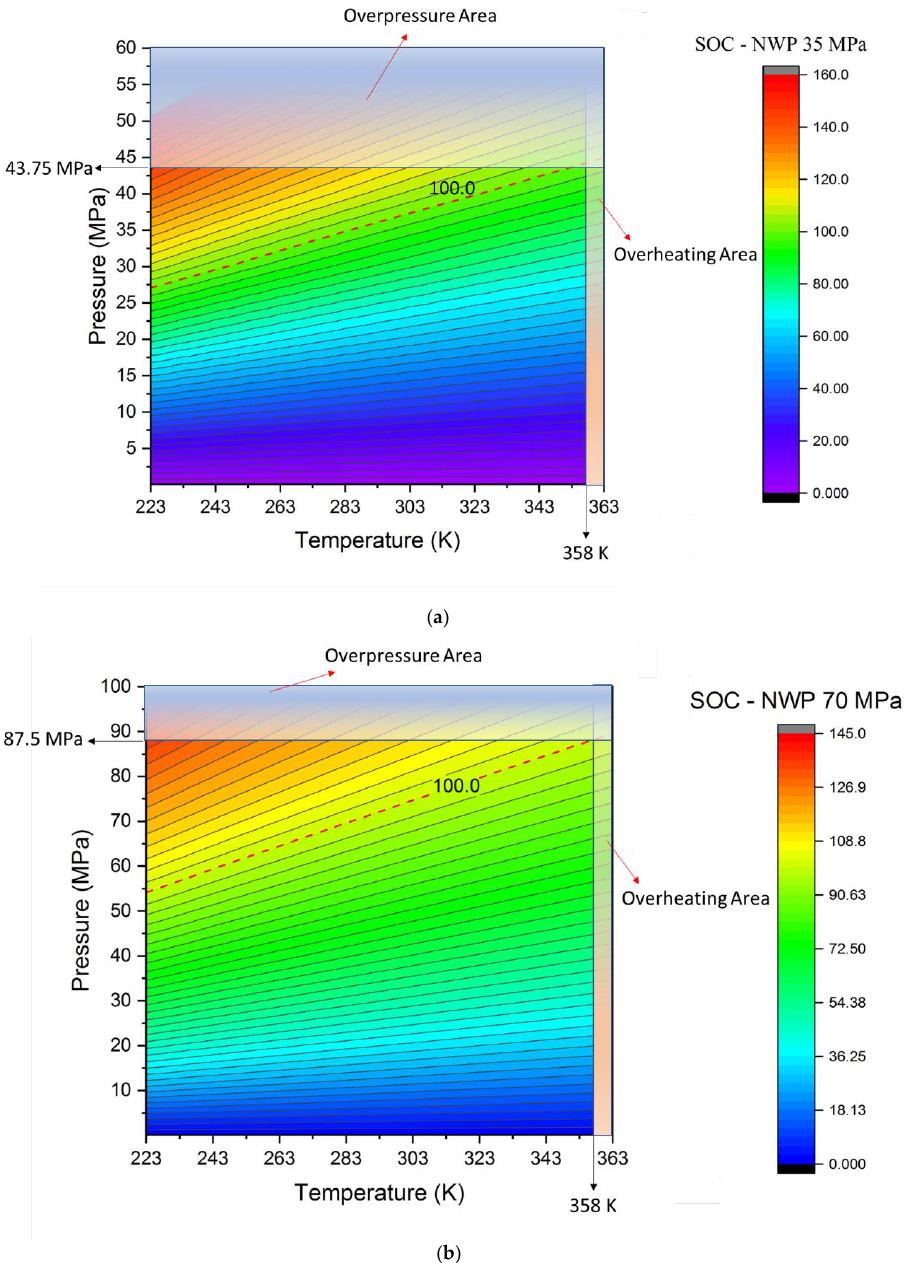
Figure 13. Allowable SOC values for 35 MPa ( a ) and 70 MPa ( b ). Table 6. Main research activities on CCHS